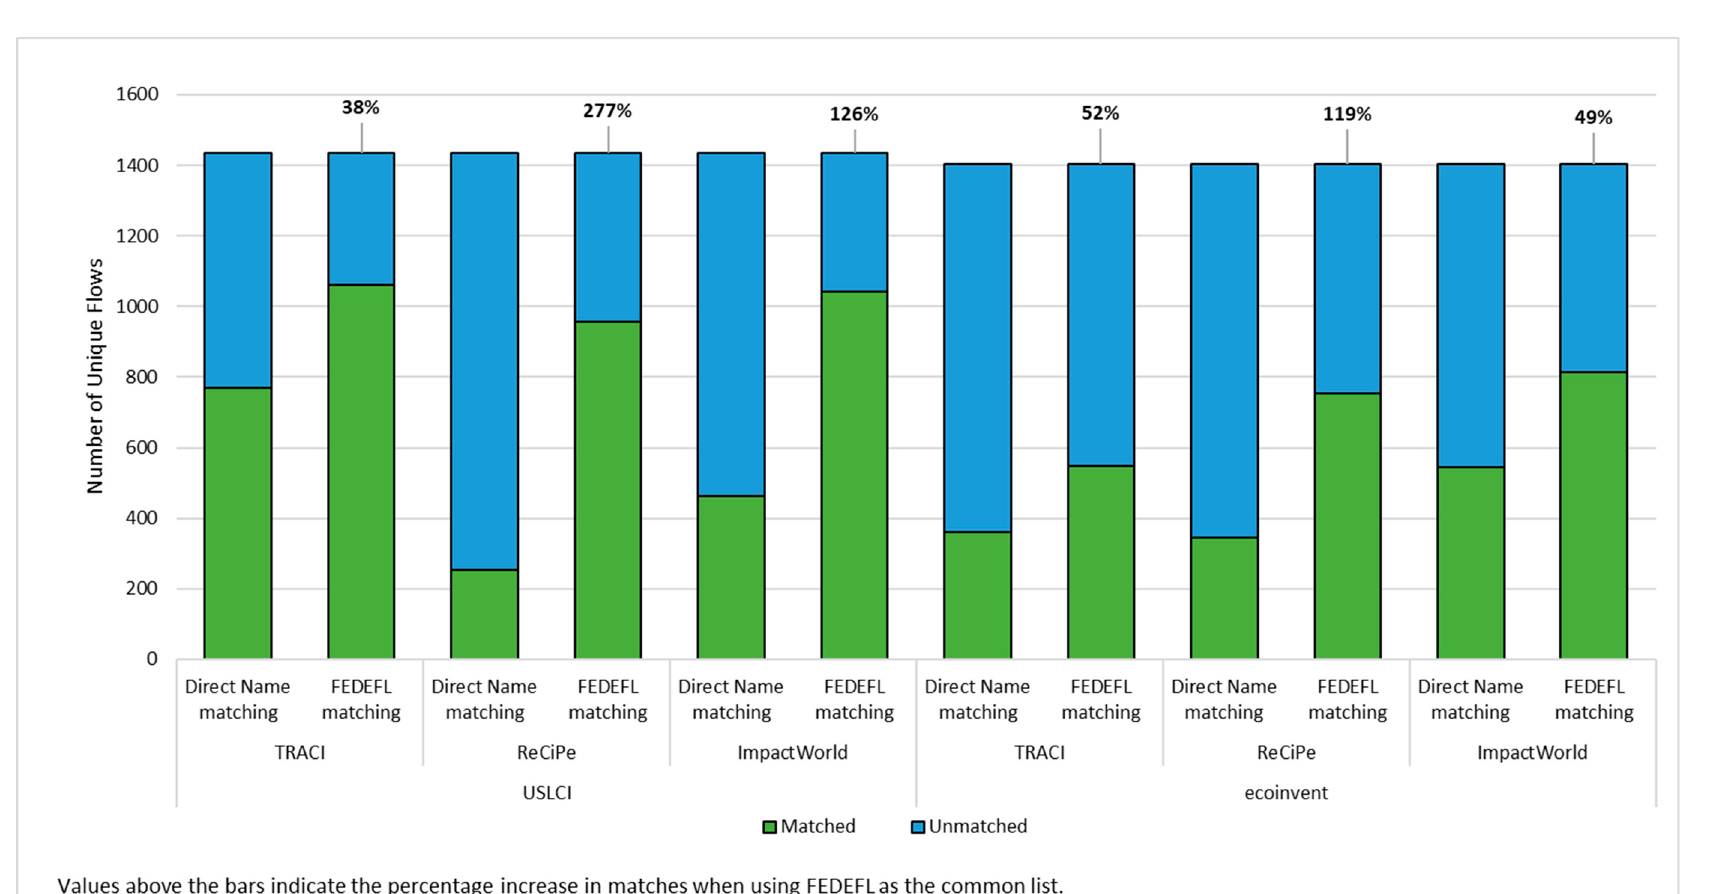
Figure 1. Analysis of improved matching using FEDEFL as the common list.